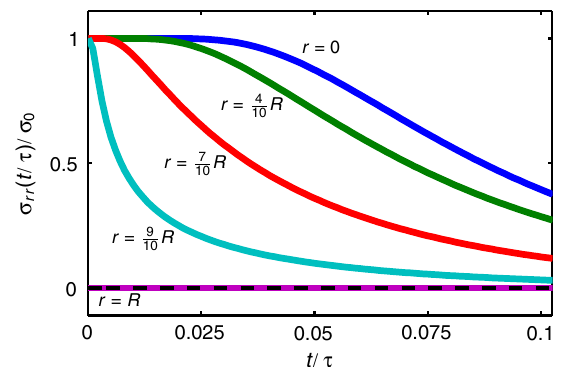
FIG. 4. The rr component of the stress tensor, 1 (cid:2) F function of time for a number of radii scaled with the initial (cid:7) V G ¼ 4 (cid:5)Q . After the addition of heat at the stress, (cid:6) 0 0 V 0 c l M T 3 immediately increases throughout the sphere. The surface, (cid:6) rr stress is released as heat diffuses toward the center from the